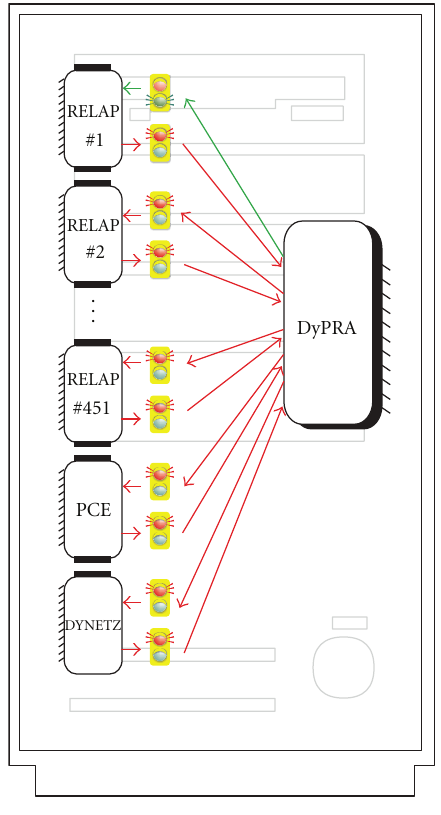
Figure 6: Schematic representation of the advancement of the simulation. DyPRA sets the “wait” semaphore of RELAP #1 to green, RELAP #1 computes one time step and sets the “ready” semaphore to green. Then, DyPRA moves on to the next RELAP, up to the last one. After that, it sets to green the “wait” semaphore and waits for the “ready” signal for both DYNETZ and PCE, in that order, and goes back to the first RELAP. Each code reads information from the correct shared memory segments after the “wait” semaphore has been turned to green and writes its output information to the memory before it sets the “ready” semaphore to